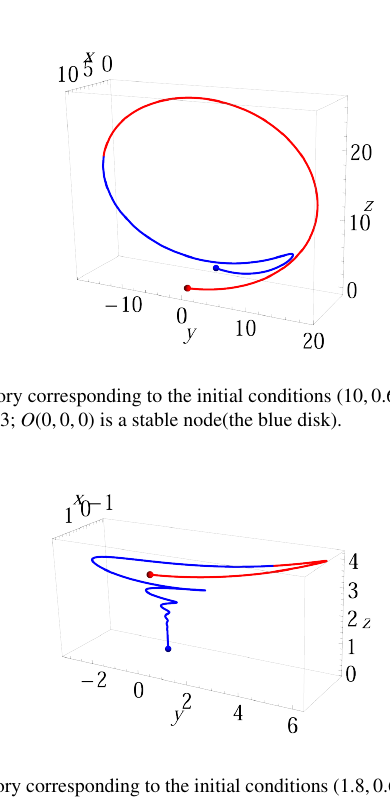
Figure 1. The chaotic attractor: an orbit of the T system corresponding to the initial conditions (0 . 01 , 0 . 01 , 14 . 01) and parameters a = 2 , b = 0 . 2 , c = 30.